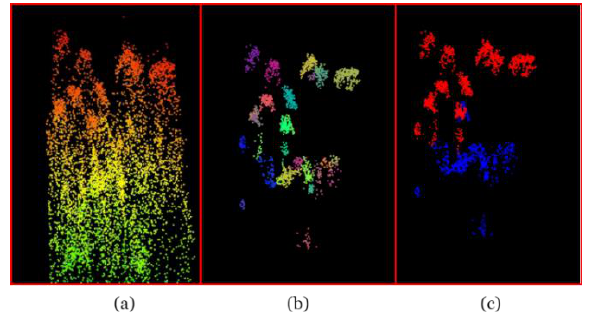
Figure 7 Voxel-based ear detection results. The size of the ears is reduced due to point cloud thinning (a) Raw point cloud, color coded based on height value. (b) Voxel- based segmentation results with each segment displayed using a random color (c) Ear classification where the red segments are the extracted ears (crops of age 225